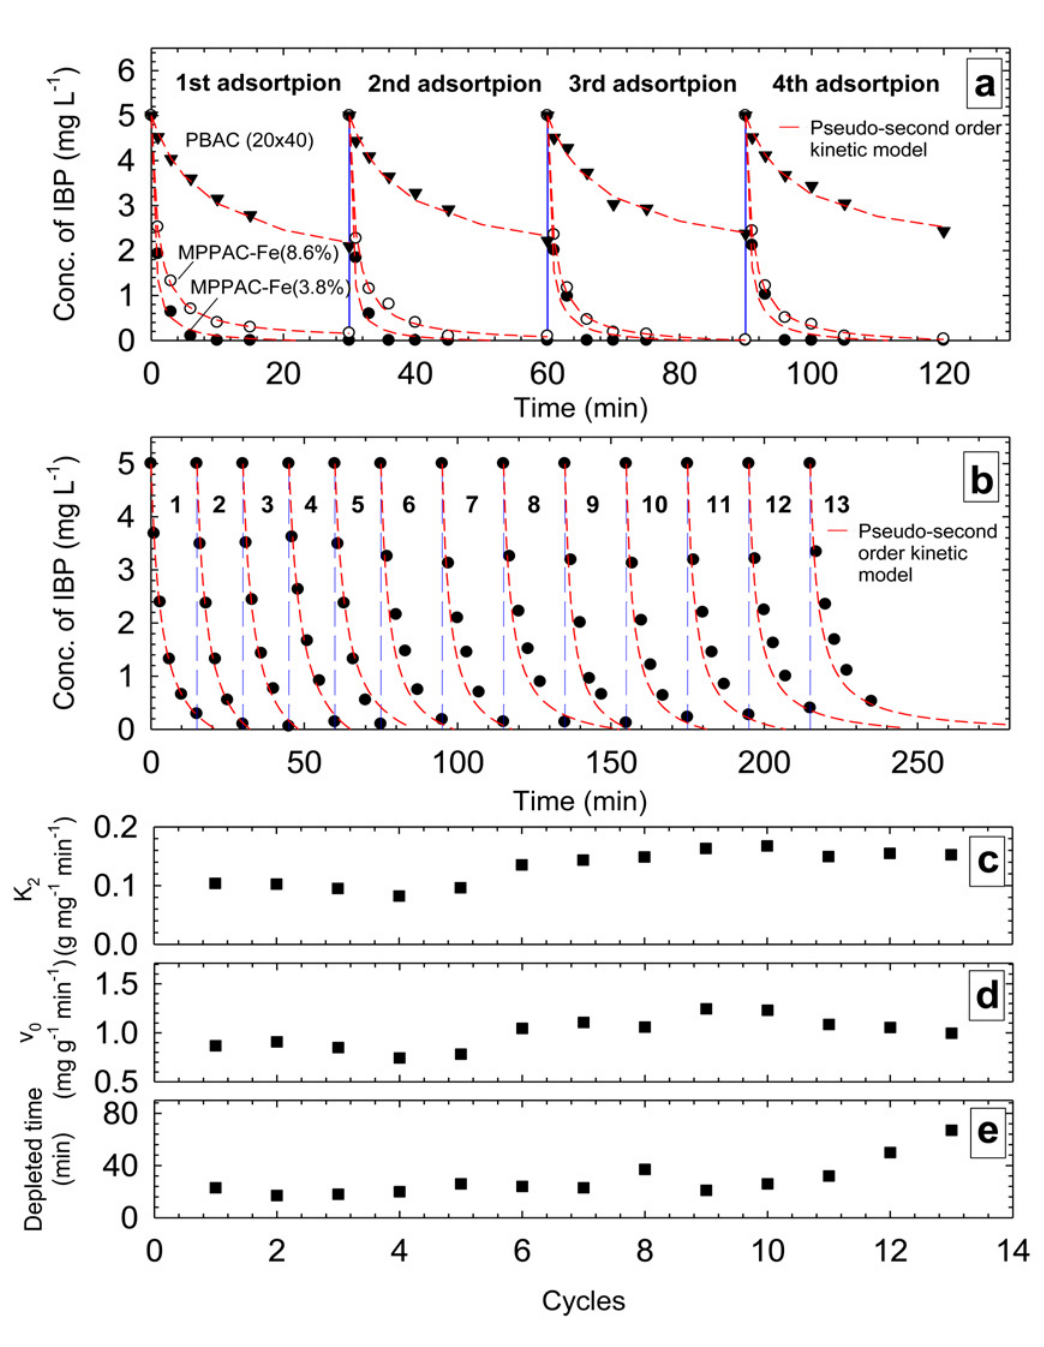
Fig 7. Repetitive removal of 5 mg L -1 IBP at pH 7.0 with 20 mg absorbent (a) 4 continuous cycles with MPPAC-Fe(3.8%), MPPAC-Fe(8.6%) and GAC, and (b) IBP removal using MPPAC-Fe(3.8%) with 13 successive cycles (Long-dashed lines denote pseudo-second order kinetic), (c-e) The adsorption rate (k 2 ), initial adsorption rate (v 0 ) and depleted time (min) was determined through pseudo second order